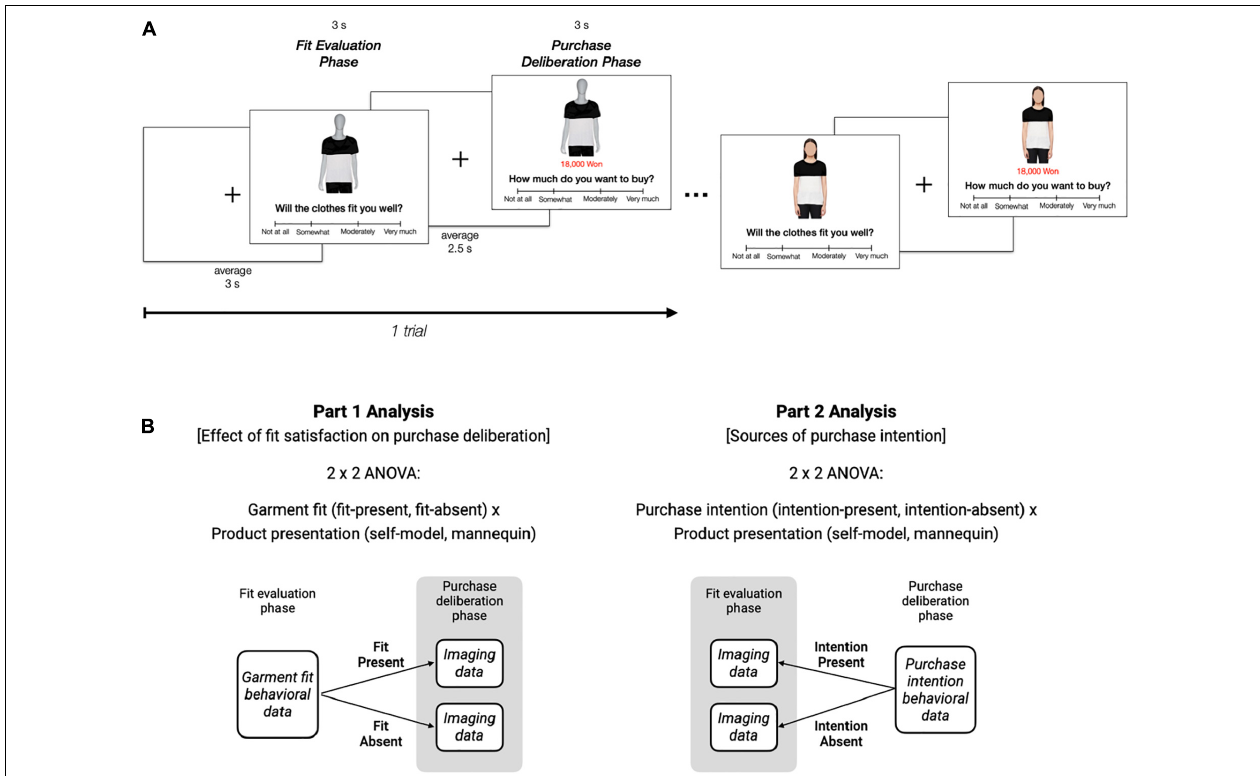
FIGURE 1 | Experimental and analysis design. (A) Each participant was presented with an apparel either on a mannequin or on a model with the participant’s face superimposed (self-model). First, participants were instructed to disclose their garment fit rating (fit evaluation phase). Next, they were asked to indicate how much they would like to purchase the clothing (purchase deliberation phase). (B) In Part 1, trials were separated based on participant’s behavioral responses of garment fit-present and fit-absent, and then neuroimaging data of the subsequent purchase deliberation phase were analyzed. In Part 2, trials were separated based on participant’s behavioral responses of purchase intention-present and purchase intention-absent, and then neuroimaging data of the previous fit evaluation phase were